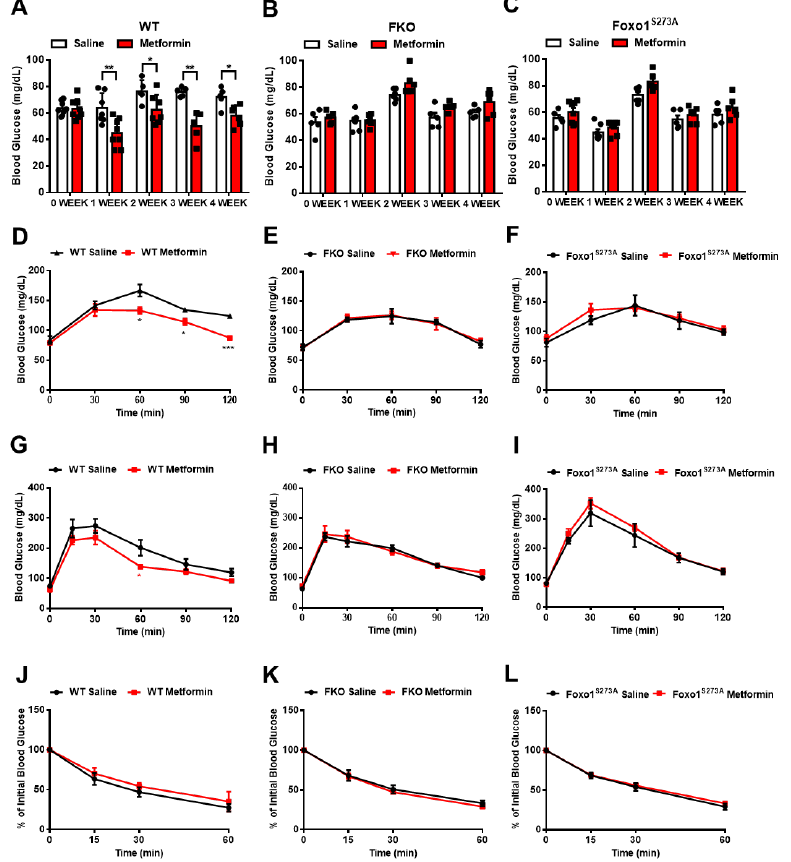
Figure 4. Chronic metformin treatment reduces blood glucose through interference of Foxo1-S273 phosphorylation. ( A – C ) Blood glucose in WT ( A ), FKO ( B ), and Foxo1 S273A ( C ) mice chronically treated with 50 mg/kg body weight metformin after 16 h fasting, n = 5–7 mice/group. ( D – F ) Pyruvate tolerance test in WT ( D ), FKO ( E ), and Foxo1 S273A ( F ) mice chronically treated with 50 mg/kg body weight metformin, n = 5–7 mice/group. ( G – I ) Glucose tolerance test in WT ( G ), FKO ( H ), and Foxo1 S273A ( I ) mice chronically treated with 50 mg/kg body weight metformin, n = 5–7 mice/group. ( J – L ) Insulin tolerance test in WT ( J ), FKO ( K ), and Foxo1 S273A ( L ) mice chronically treated with 50 mg/kg body weight metformin, n = 5–7 mice/group. All data are presented as mean ± SEM. * p < 0.05, ** p < 0.01, *** p < 0.001.